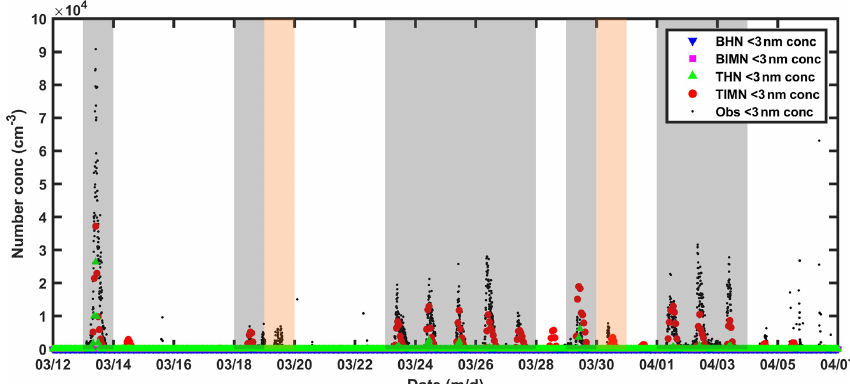
Figure 6. Comparison of observed sub-3nm particle number concentrations with those simulated on the basis of BHN, BIMN, THN, and TIMN schemes during the measurement period. The identified NPF days and undefined days are shaded with a grey and orange background,